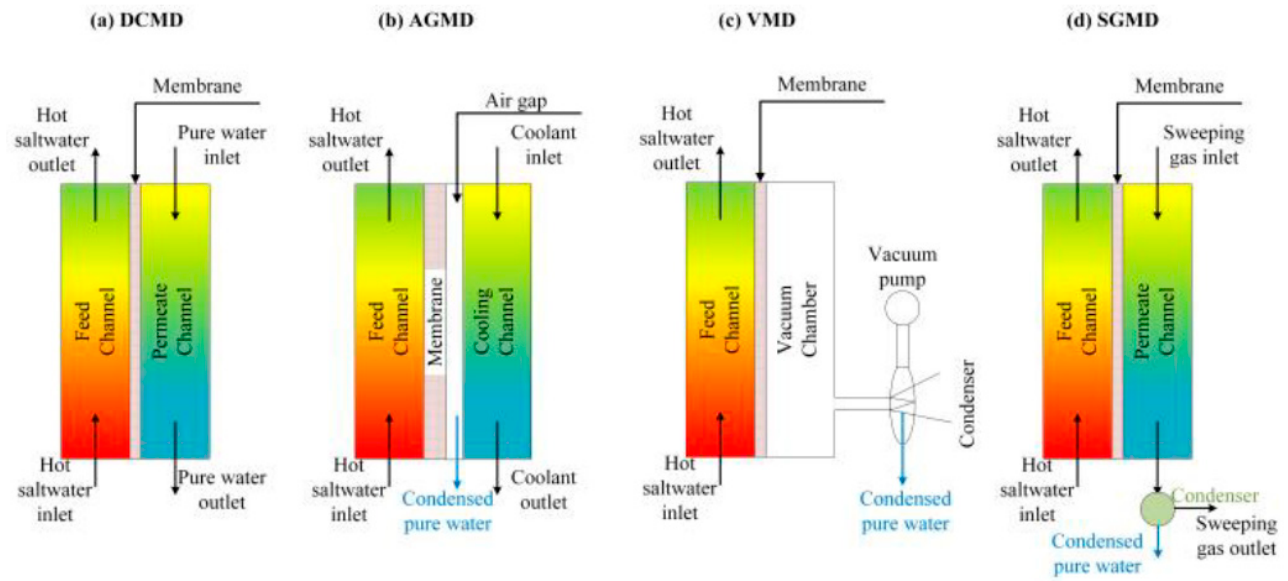
Figure 1. The major types of membrane distillation ( a ) DCMD, ( b ) AGMD, ( c ) VMD, and ( d ) SGMD.